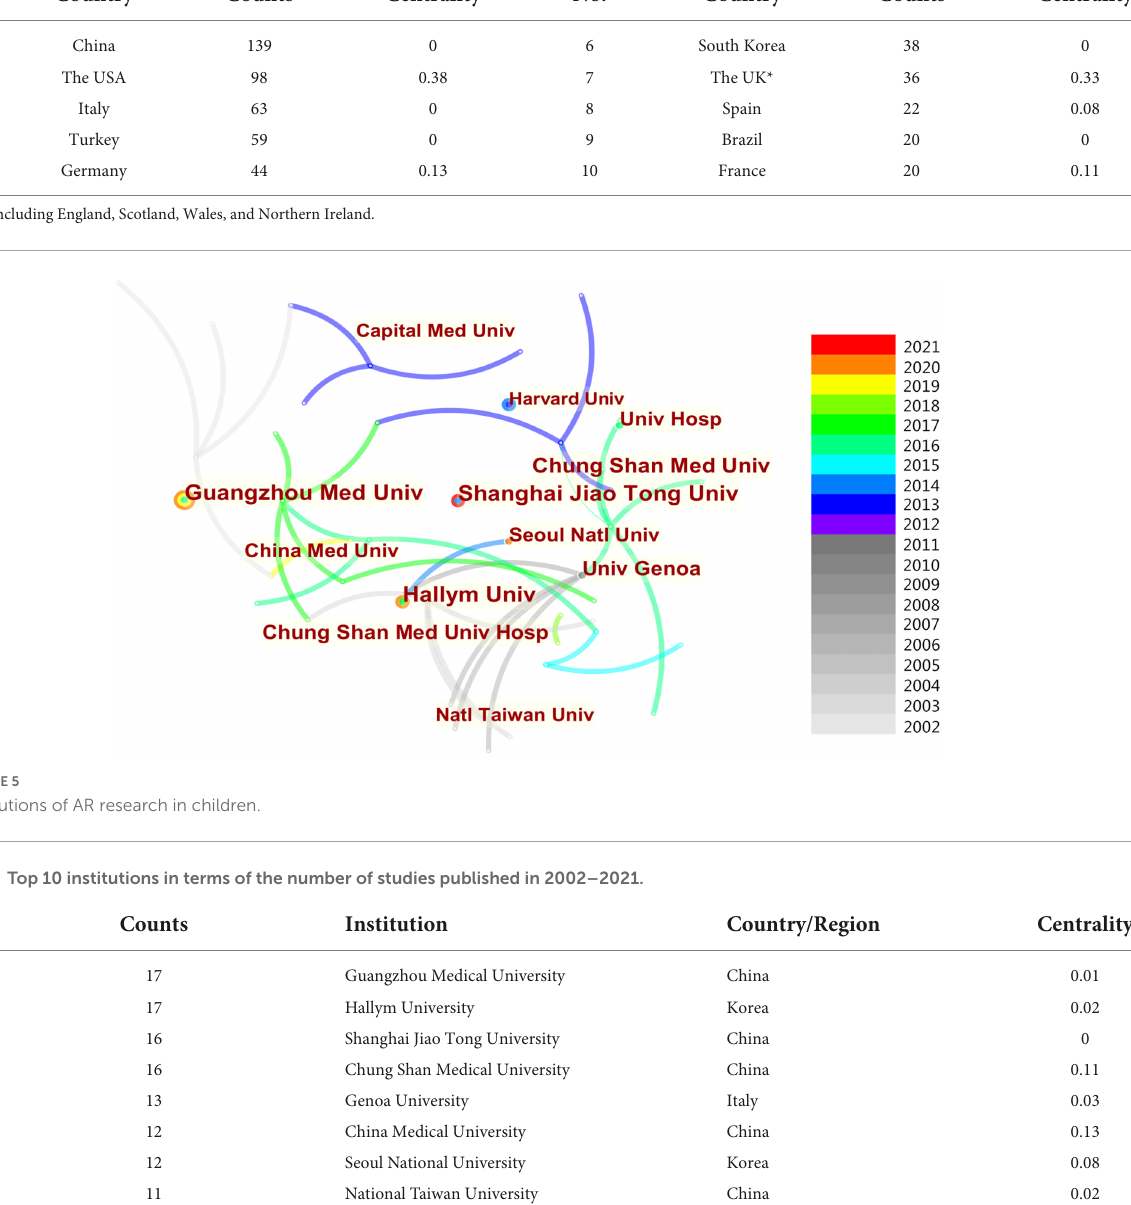
TABLE 2 Top 10 countries in terms of the number of studies published in 2002–2021. No.